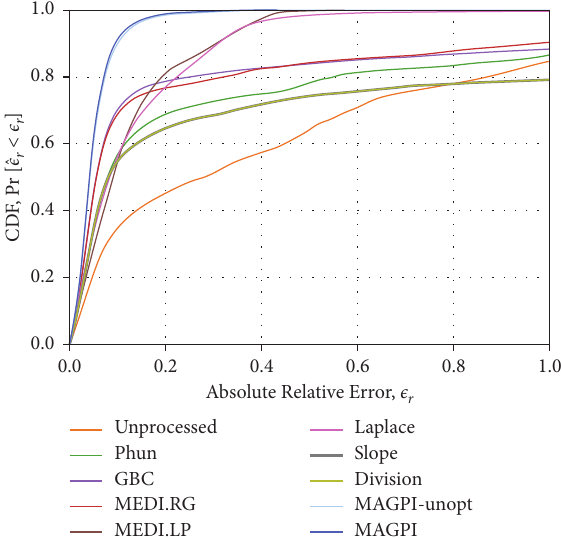
Figure 5: CDF F of the absolute relative error obtained for each of the phase estimation methods studied in this work, when the error is ε r pooled over all sequences, slices, tubes, angles, and frequency referencing ROIs. Note that some methods do not converge to probability of 1, due to the presence of errors greater than 100%.